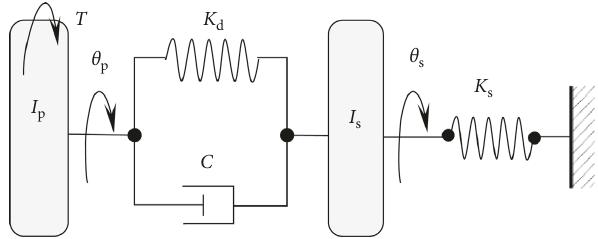
Figure 2: 2-degree-of-freedom driveline vibration